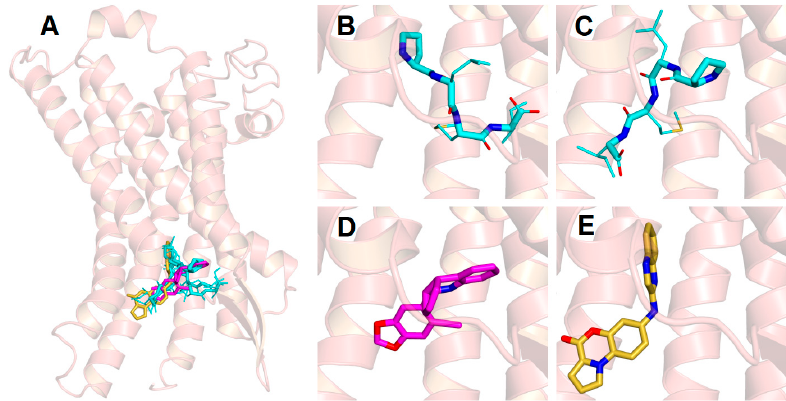
Figure 8. Docking and molecular dynamics (MDs) of ligands/GPER complexes. The GPER is shown as semi ‐ transparent (ribbon), with the disordered region 1–50 omitted. Hydrogen atoms are omitted in all panels. Side chains are represented as smaller sticks compared to the backbone, with the